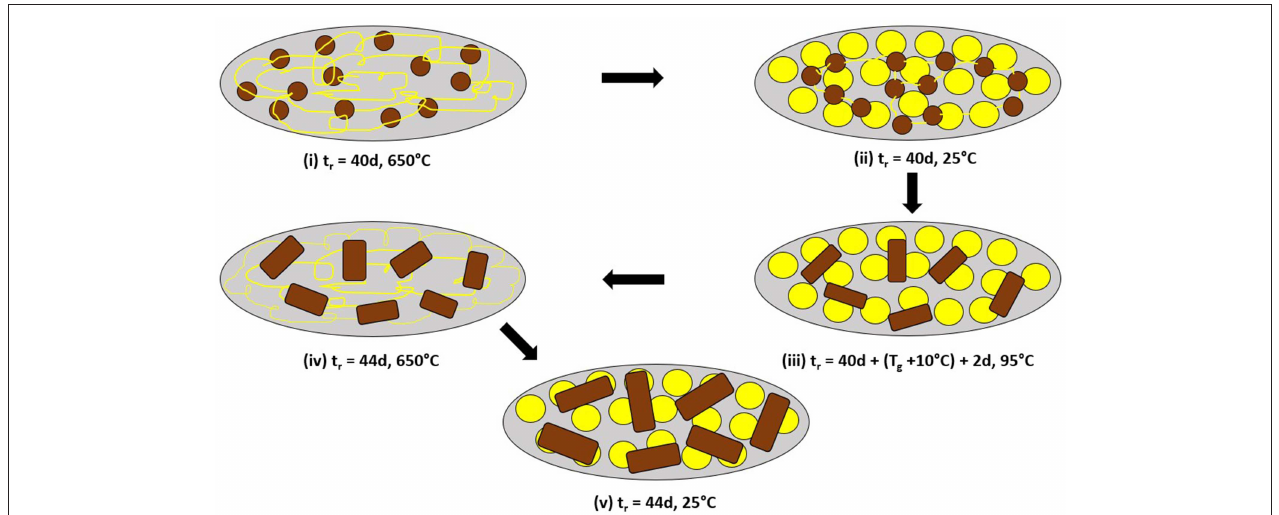
FIGURE 5 | Schematic representation of structural changes underlying the coalescing of backbone fragments (from small brown circles to larger rectangles), and leading to the observation of the 537 cm − 1 mode in As 18 S 82 glass as shown by the Raman scattering results of Figures 4D–F . In (i) after 40d of alloying at 650 ◦ C, the melt is viewed to be composed of As 18 S 82 –rich circular domains immersed in a sea of polymeric S n chains (thin yellow lines). (ii) After a water quench, the S n –rich chain regions transform into the more stable S 8 rings, largely decoupled from the glassy backbone. (iii) Heating the quenched glass to 95 ◦ C for 2d, results in softening and diffusion of the backbone fragments to coalesce and form the larger rectangular domains. (iv) Heating the glass to 650 ◦ C leads more S n chains to be alloyed in the backbone, and finally (v) Upon a water quench to 25 ◦ C leads to their growth. Confirmation is given by Raman scattering that shows the S 8 –ring fraction to qualitatively decrease in going from Figure 4E → 4F .